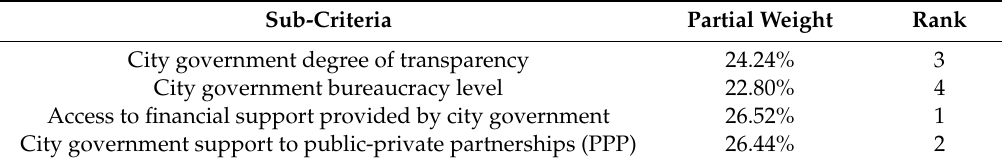
Table 9. Sub-criteria relative weight and rank of the city’s government and its policies.